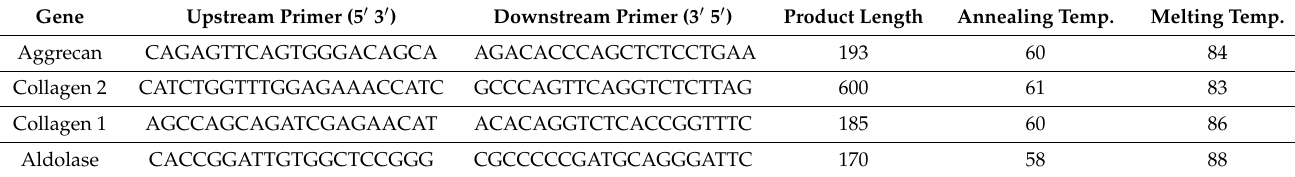
Table 1. Primers, product length, and specific amplification conditions for RT-PCR. Gene Upstream Primer (5 (cid:48) 3 (cid:48) )